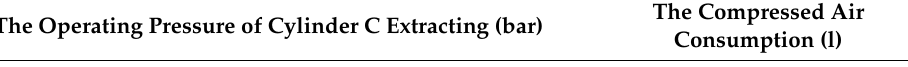
Table 1. The theoretical compressed air consumption of the circular manipulator per cycle. The Operating Pressure of Cylinder C Extracting